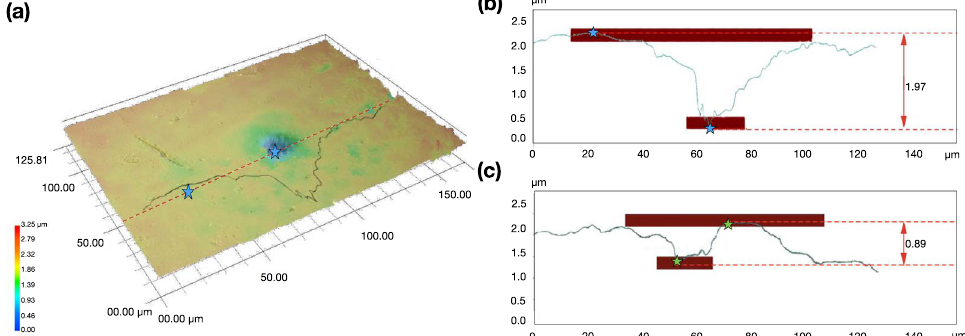
Figure 3. ( a ) Optical micrographs and ( b ) cross-sectional profile of the laser exposed areas of the SWNT-PVA film after 40 hours of continuous laser radiation exposure with an optical fluence of 2.3 mJ·cm − 2 ; ( c ) Cross- section profile of SWNT-PVA film after 10 min laser exposure with 0.9 mJ · cm − 2